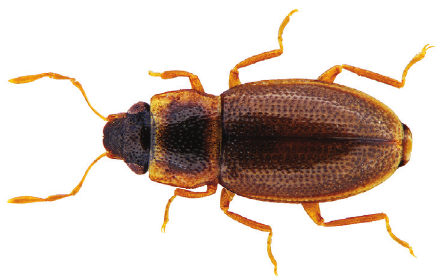
Figure 37. Hydraena cooperi Balfour-Browne, 1954 1.5 mm, iSimangaliso Wetland Park, Catalina Bay (site 32), February 2015 DT Bilton, MS Bird & R Perissinotto leg.